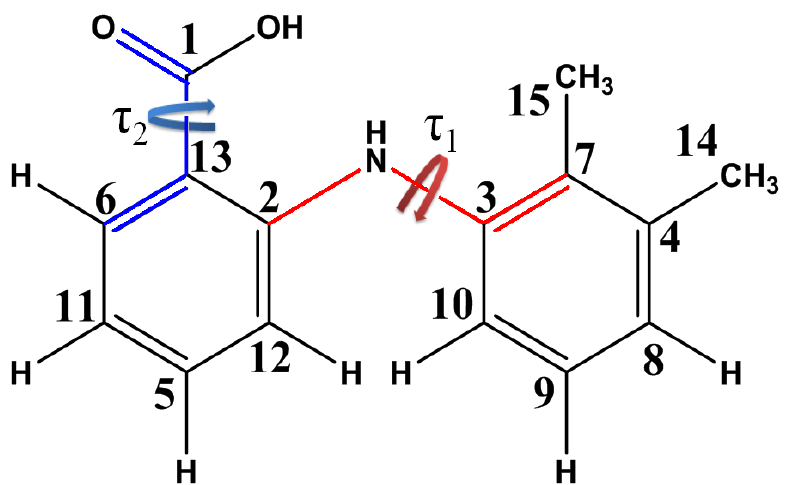
Figure 2. Structural formula of MFA. Atom numbering is used below for labeling signals and cross-peaks in NMR spectra and for denoting dihedral angles. Chemical bonds forming the dihedral angle τ 1 [C 2 -N-C 3 -C 7 ] are shown in red; τ 2 [O=C 1 -C 13 -C 6 ], in blue.